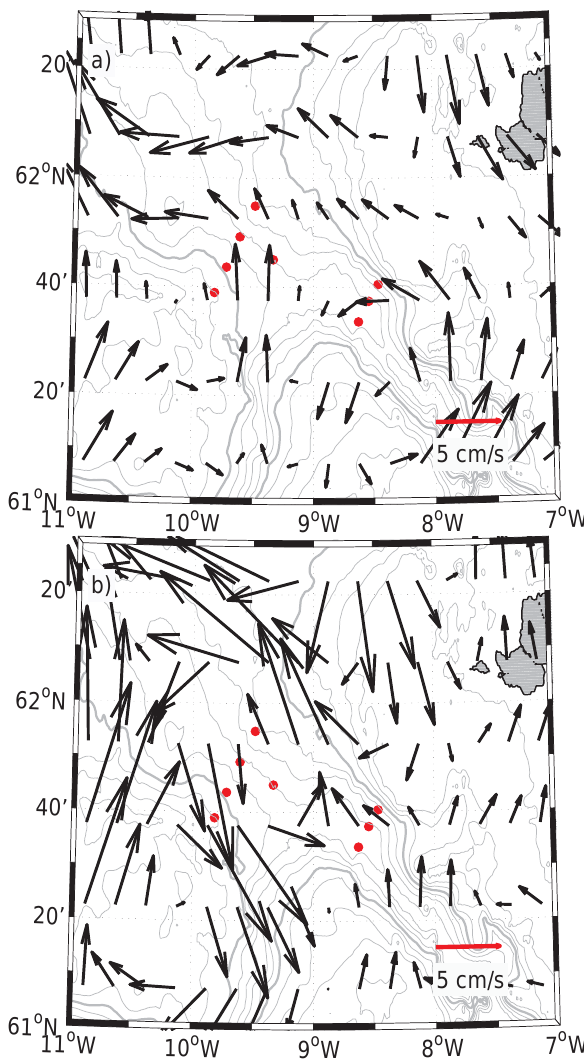
Figure 12. Mean geostrophic velocity anomaly (from AVISO) dur- ing the period (a) 1–31 May 2008 and (b) 3–10 June 2008. The red dots mark the positions of the moorings deployed in 2012–2013.